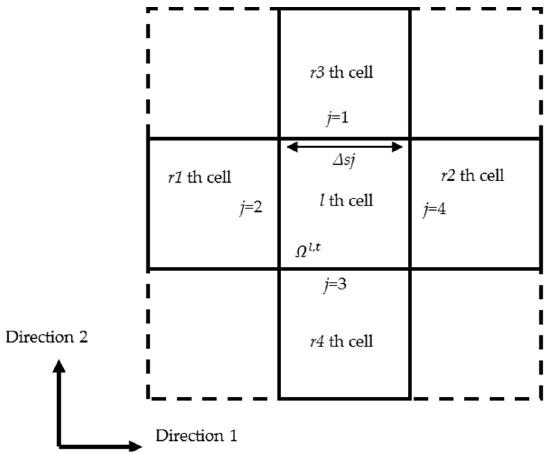
Figure A1. Geometry of the cells.